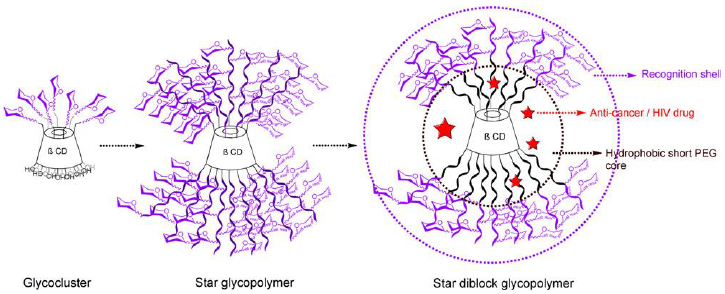
Figure 12. Sugar clusters, star type glycopolymers and star block type glycopolymers. Figure reproduced from ref. [56] with permission.